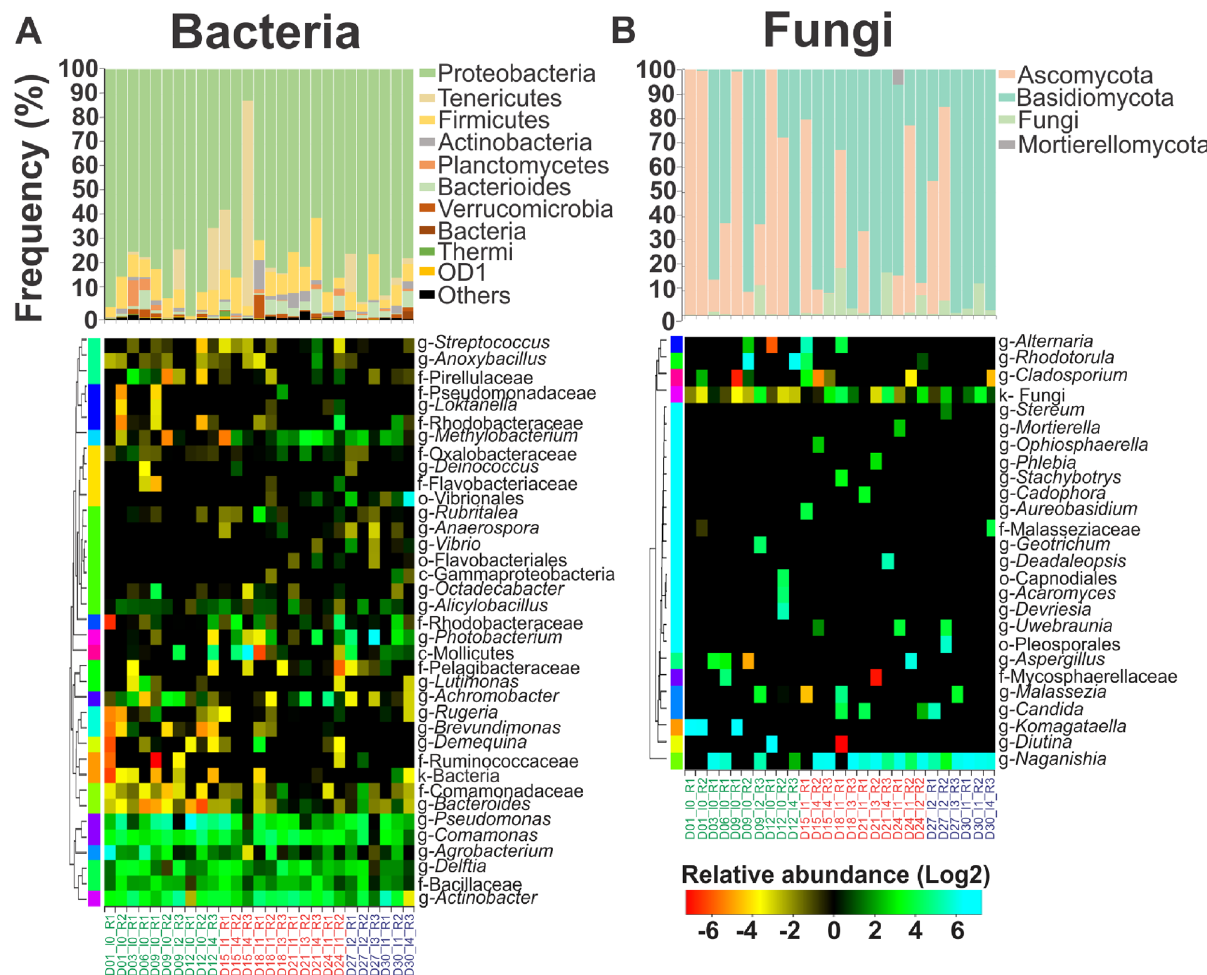
Figure 4. Shrimp microbiome at phyla and genera level registered at different disease stages. Microbiome modulation for ( A ) bacteria and ( B ) fungi taxa. Relative abundance is expressed as a percentage for phyla, where only phyla with higher relative abundance than 1% in at least one of the replicates are shown. Heatmaps using Log2 transformed relative abundance were used to cluster (y axis) genera present in similar conditions. Only genera with higher relative abundance than 1% in at least one of the replicates are shown. Shrimp were grouped (x axis) by the disease stage (early in green, development in red and late in blue) for easy visualization of the microbiome change between healthy and infected shrimp. The heatmaps color key ranges from orange for low abundant (< 1%) microorganisms to cyan for high abundant microorganisms (1–90%). Letters p- (phyla), c- (class), o- (order), f- (family) and g- (genera) on the left side of the taxa name represent the group